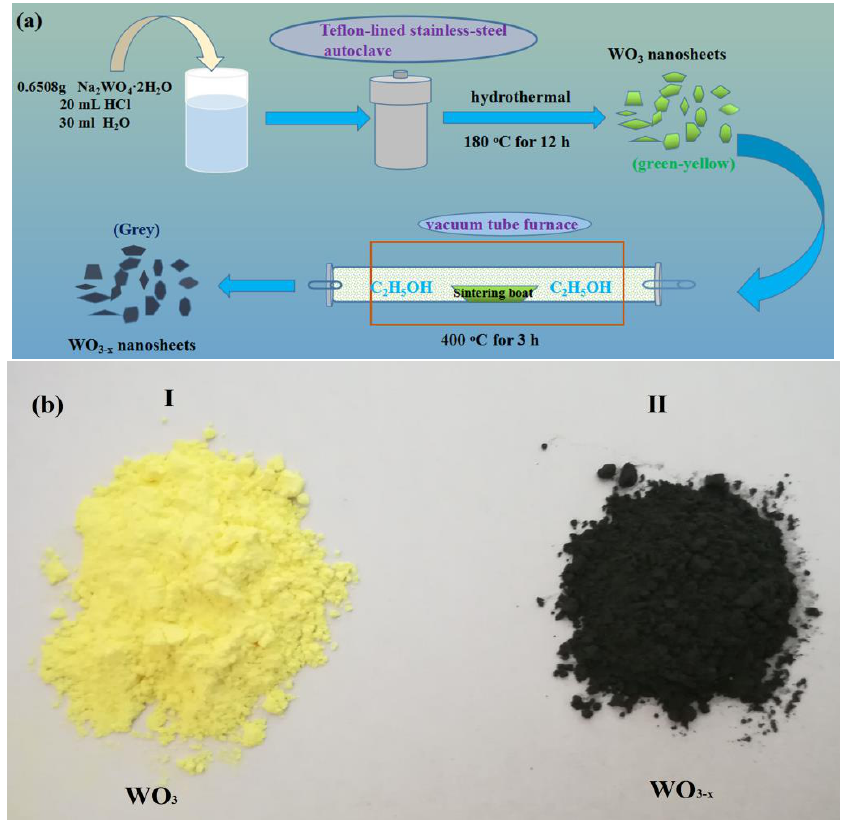
Figure 1. ( a ) Schematic illustration of the fabrication of tungsten trioxide (WO 3 ) and non-stoichiometric monoclinic structured WO 3 (WO 3 − x ) nanosheets. ( b ) Digital photos of the WO 3 (I) and WO 3 − x (II) nanosheets